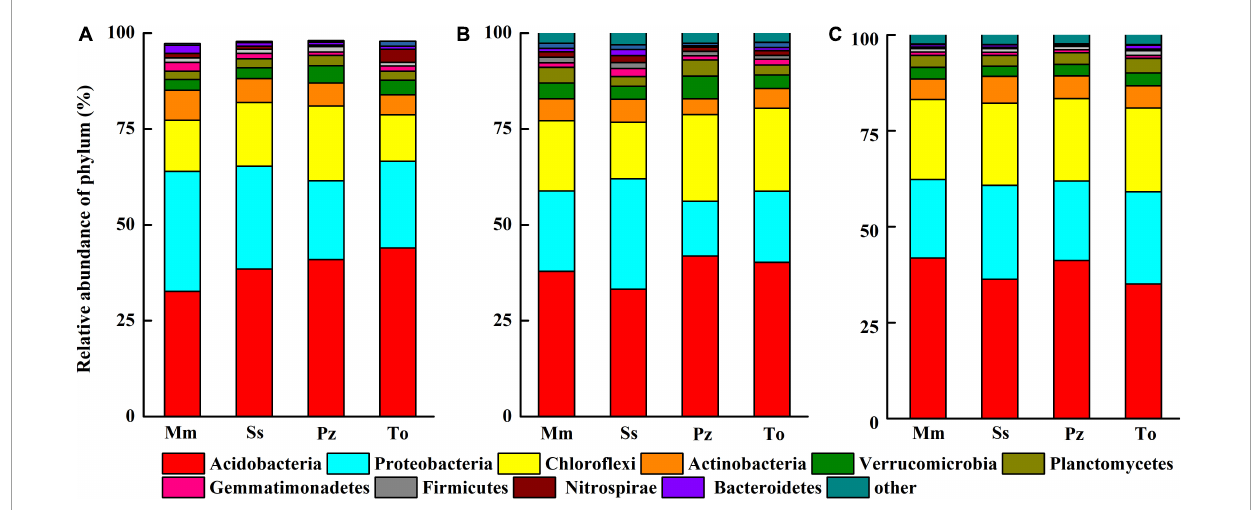
FIGURE1 The relative abundance of dominant bacterial phyla in the rhizosphere soils of four broad-leaved tree species under 900 stems ha − 1 (A) , 1,200 stems ha − 1 (B) and 1,875 stems ha − 1 (C) of stocking density. The Mm, SS, Pz and To stand for Michelia macclurei, Schima superba, Phoebe zhennan , and Tsoongiodendron odorum ,